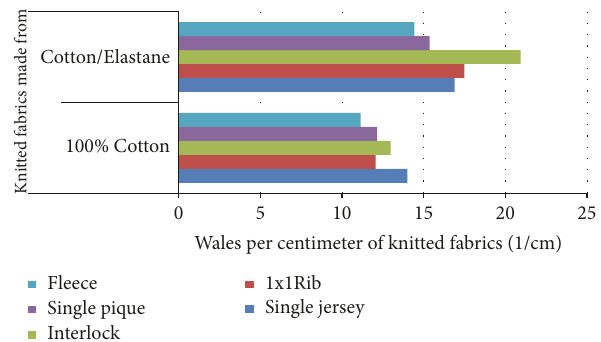
Figure 2: Wales per centimeter of knitted fabrics made from 100% cotton and cotton/elastane yarns.